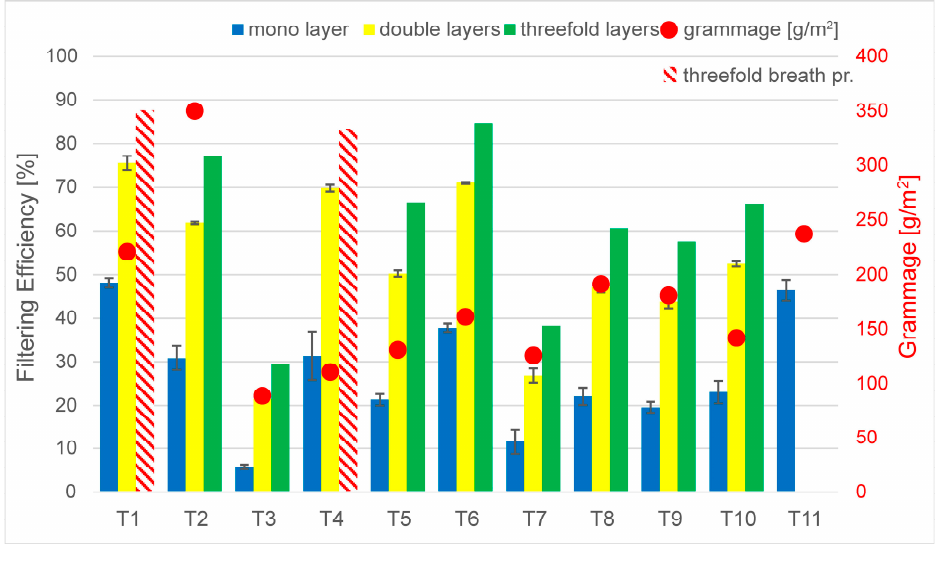
Figure 4. Filtering efficiency versus grammage.